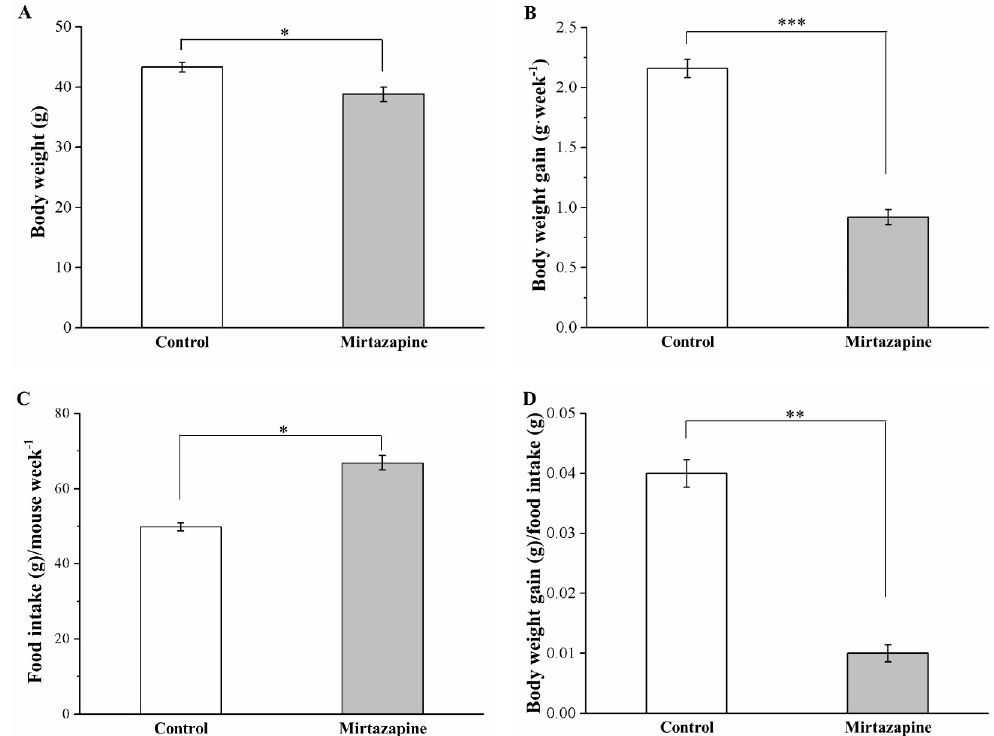
Figure 1. Changes in ( A ) body weight, ( B ) body weight gain, ( C ) food intake (per mouse per week), and ( D ) daily food efficiency in the control and 10 mg/kg/day mirtazapine-treated mice over the 28 treatment days. We present all data in this figure as mean ± SEMs (n = 10) for both groups. * p < 0.05, ** p < 0.01, *** p < 0.001.